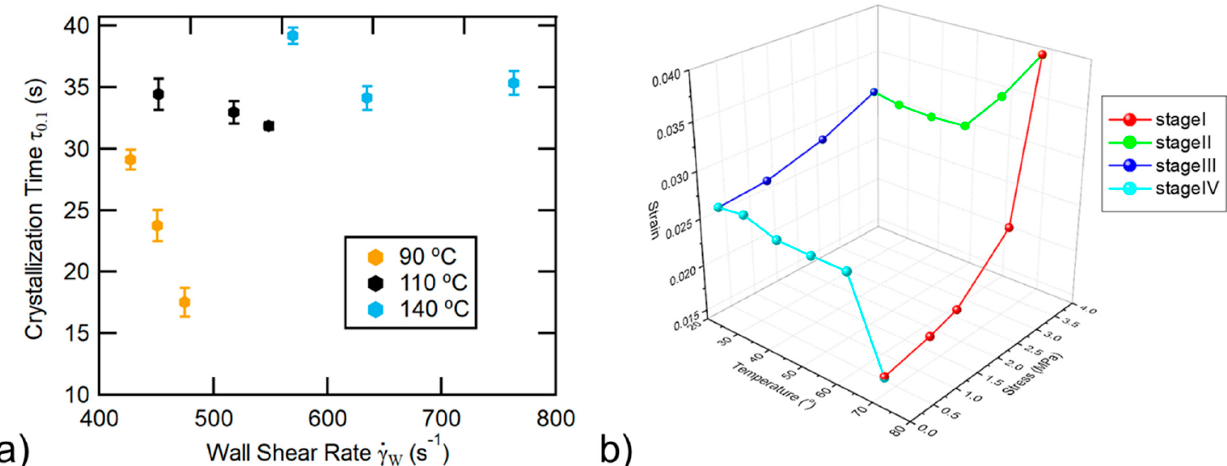
Figure 7. Thermal and mechanical molecular behavior of 3D printed TP: ( a ) crystallization kinetics of PCL as a function of nozzle wall shear rate and temperature [60] (copyright (2018), with permission from Elsevier), and ( b ) amorphous chain orientation mechanisms of PLA nanocomposite upon cyclic stress and thermal solicitations (increase in strain = decrease in distance between chain, and inversely) (stage I: stress loading at 70 °C, stage II: cooling down to 22 °C at the maximum stress level, stage III: stress unloading at 22 °C, and stage IV: heating up to 70 °C without stress) [67] (copyright (2019), with permission from Elsevier).